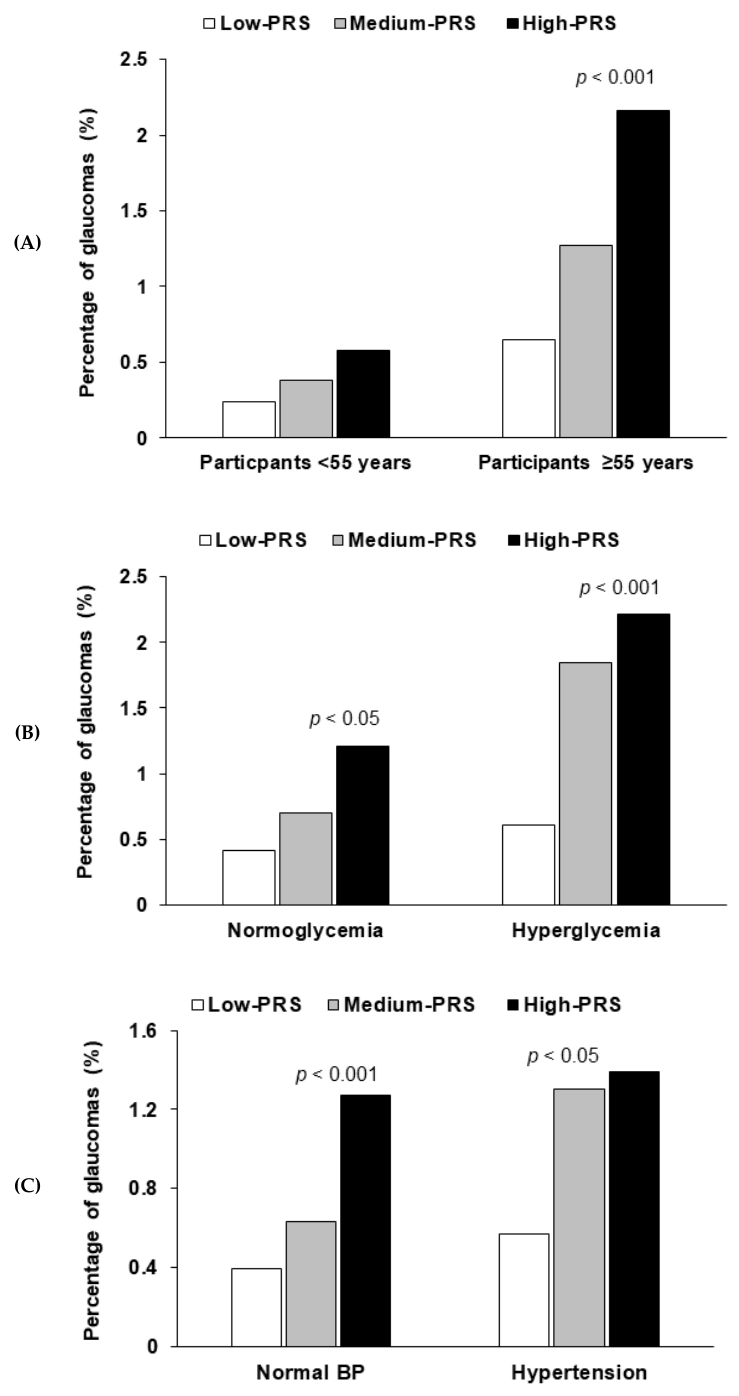
Figure 2. The frequency distribution of glaucoma in the three groups of polygenetic-risk scores (PRS) of the best model including LDB2 rs3763969, CDKN2B rs523096, ABO rs2073823, PDE3A rs12314390, and CDH13 rs12449180 according to the metabolic status. ( A ) According to age (cutoff point: 55 years old). ( B ) According to serum glucose concentrations (cutoff point: 126 mg/dL serum glucose concentrations). ( C ) According to the blood pressure (cutoff point: 130 mmHg for systolic blood pressure (SBP) and 90 mmHg for diastolic blood pressure (DBP)). PRS was calculated by the summation of each genetic-risk score of the best model, and PRS was categorized into three groups by the tertiles (Low-PRS, Medium-PRS, and High-PRS). BP, blood